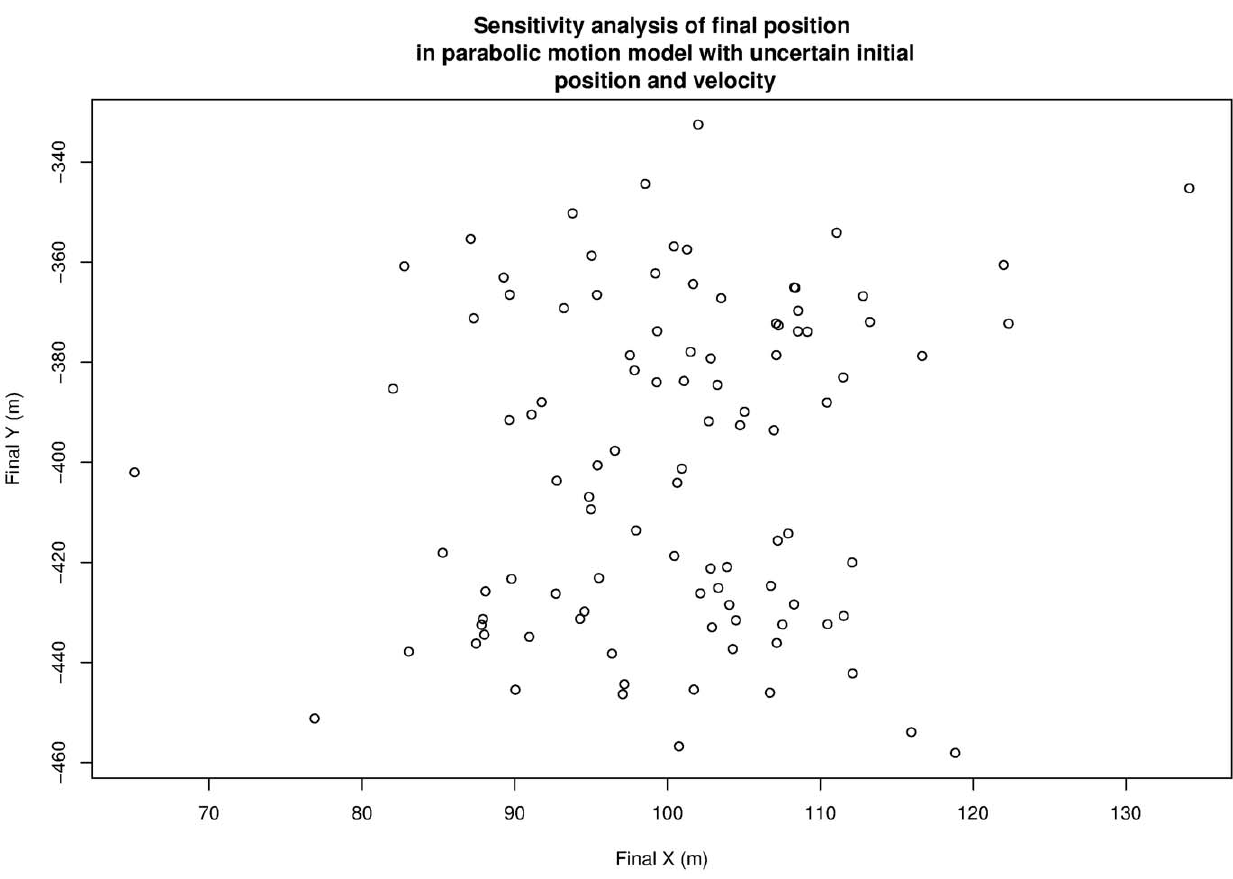
Figure 3. A sensitivity analysis of the example model, showing the position of the object at time 10 s. Generated using Model S1.